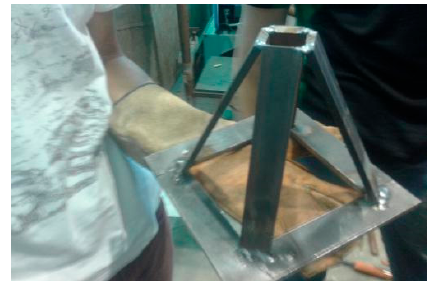
Figure 15. Student’s Project Work (1). Electronics 2020 , 9 , x FOR PEER REVIEW 22 of 28